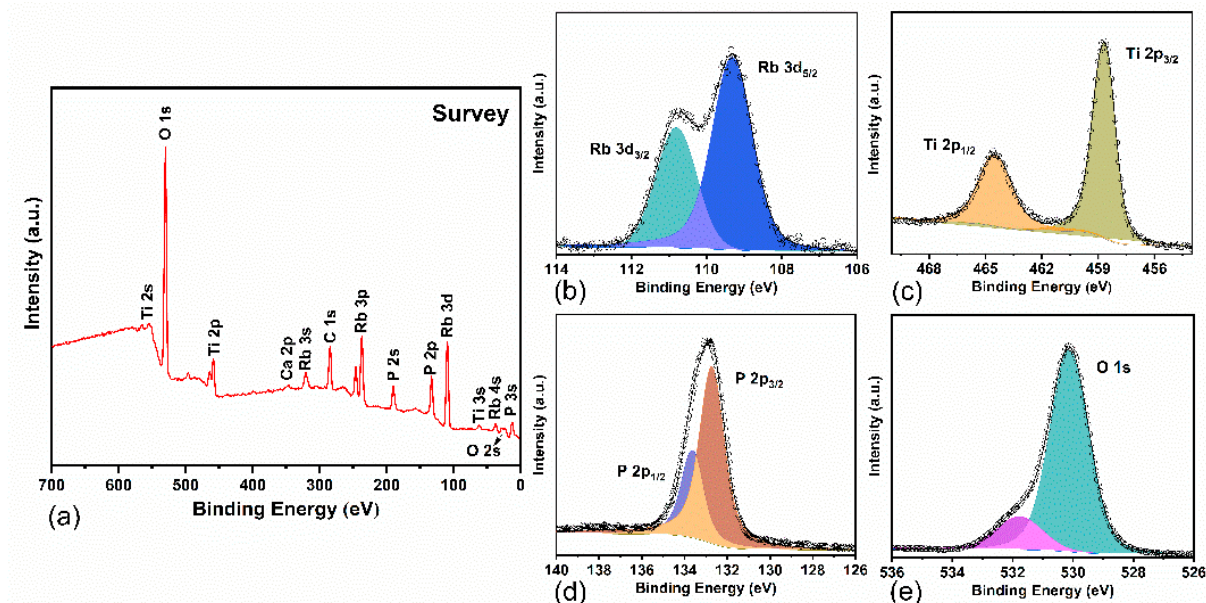
Figure 4. ( a ) Survey XPS spectrum of Rb 3 Ti 3 P 5 O 20 crystal. The corresponding element peaks are marked in the spectrum; ( b – e ) High resolution XPS spectra recorded for Rb 3 Ti 3 P 5 O 20 crystal. The deconvoluted high-resolution XPS spectra [27,28], of major elements in Rb 3 Ti 3 P 5 O 20 crystal are shown in Figure 4b–e. The binding energy (BE) values and the BE difference of the constituent elements of the title compound are presented in Table 2. RbTiOPO 4 (RTP) and KTiOPO 4 (KTP) are given for comparison. The BE values of Rb 3d 5/2 , Ti 2p 3/2 , P 2p, and O 1s